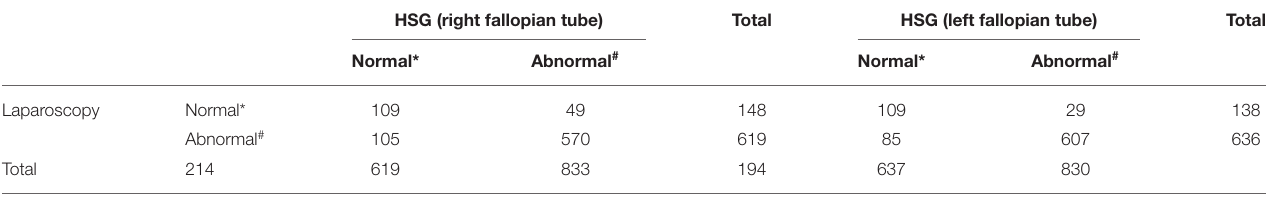
TABLE 2 | Diagnostic values of unilateral fallopian tube by HSG vs. laparoscopy. HSG (right fallopian tube)